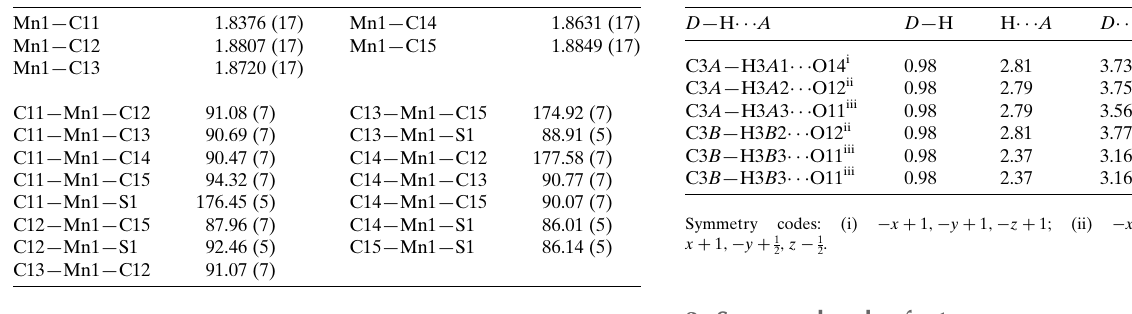
Table 1 Selected geometric parameters (A˚ , (cid:4) ).